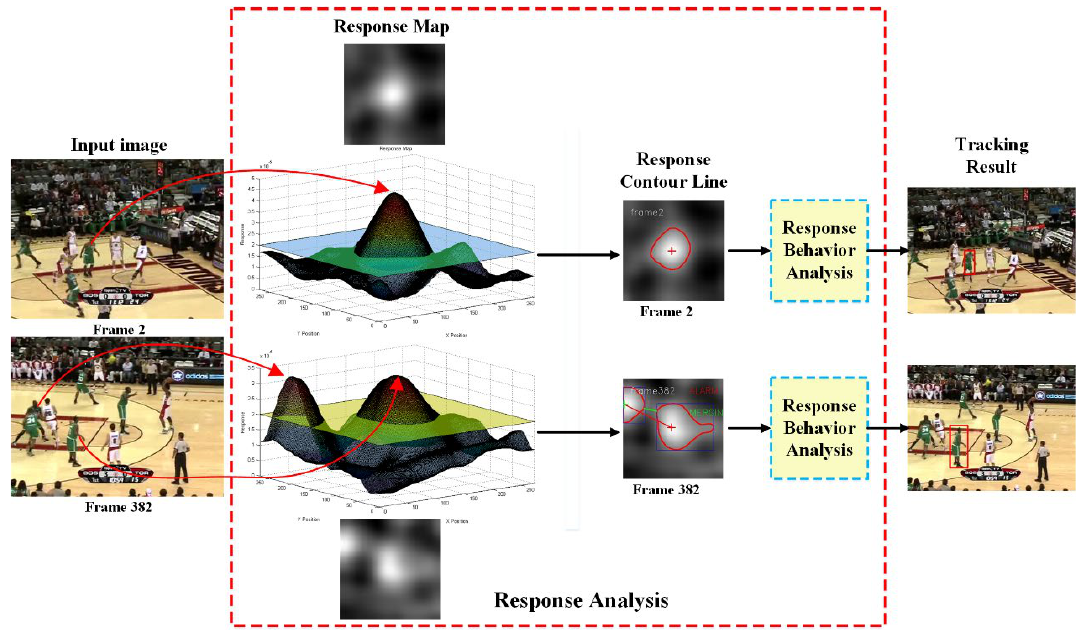
Figure 3. Overview of the proposed response analysis.